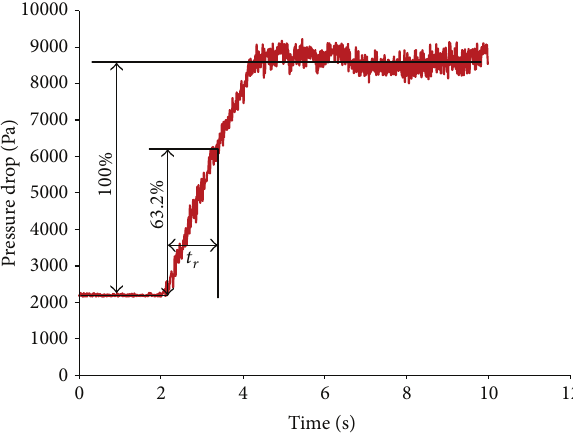
Figure 3: The temporal pressure behavior of the ER fluids ( 𝐸 = 1.0 kV/mm, V = 2